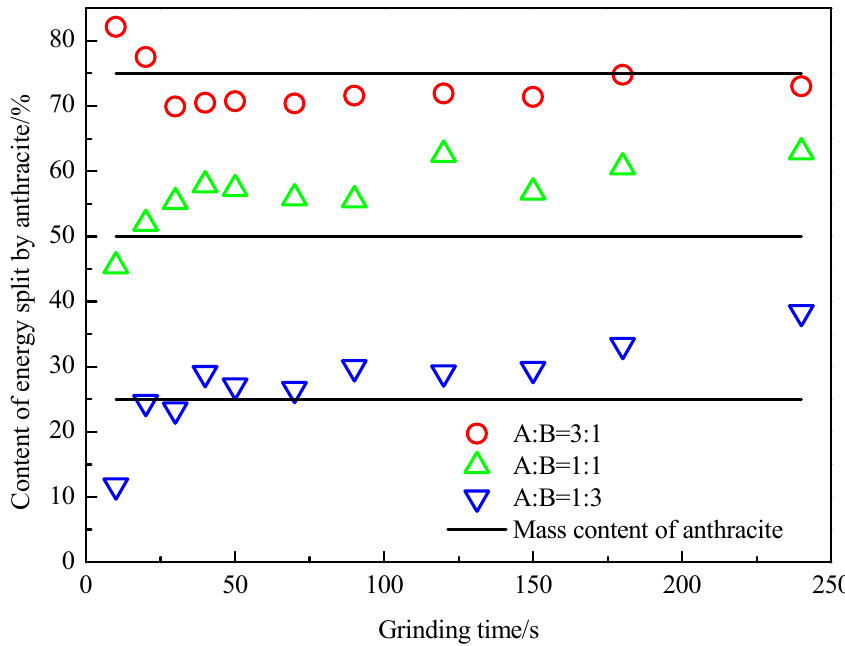
Figure 10. Content of energy split by anthracite in various grinding conditions and times.